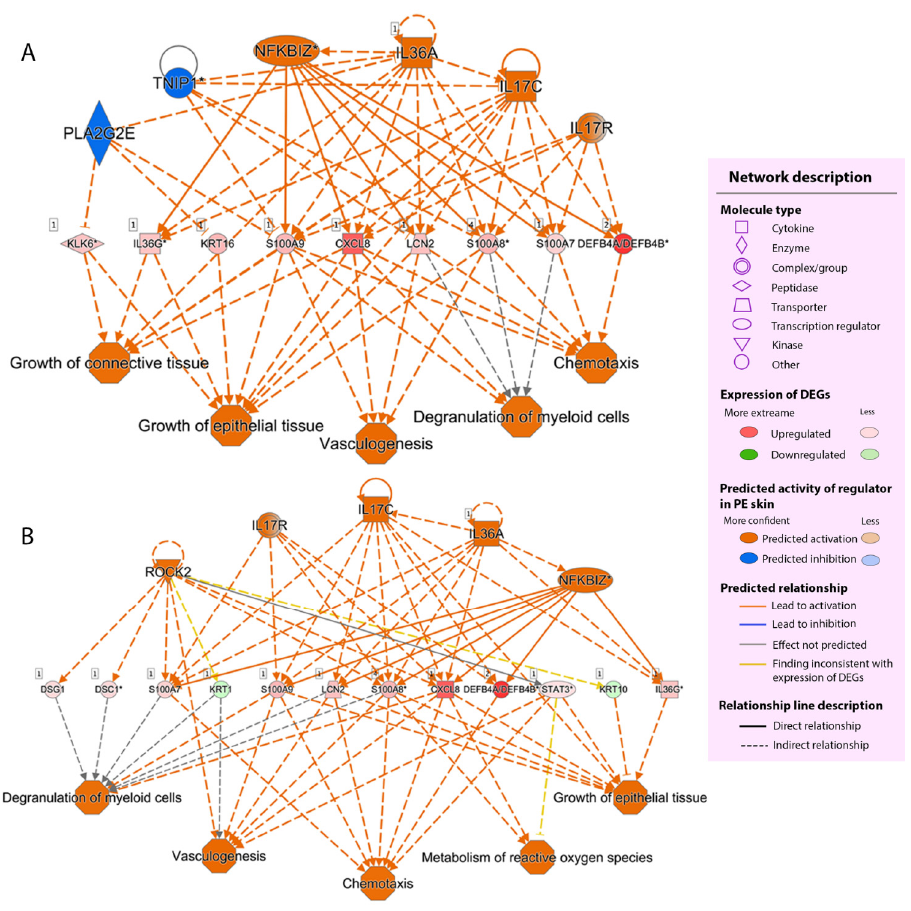
Figure 6. The two most useful regulator effect networks. ( A ) The highest consistency score network. ( B ) The second-highest consistency score network. Each network shows how predicted upstream regulators (top tier) control their dataset’s DEGs (middle tier) and the downstream functions of the dataset’s DEGs (bottom tier). DEGs, differentially expressed genes; PE skin, peripheral edge of the lesional